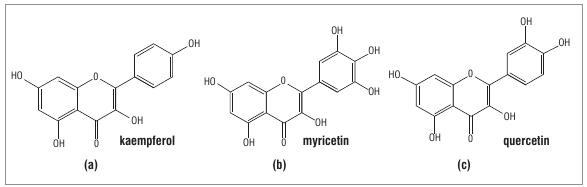
Figure 1: Chemical structures of (a) kaempferol, (b) myricetin and (c)